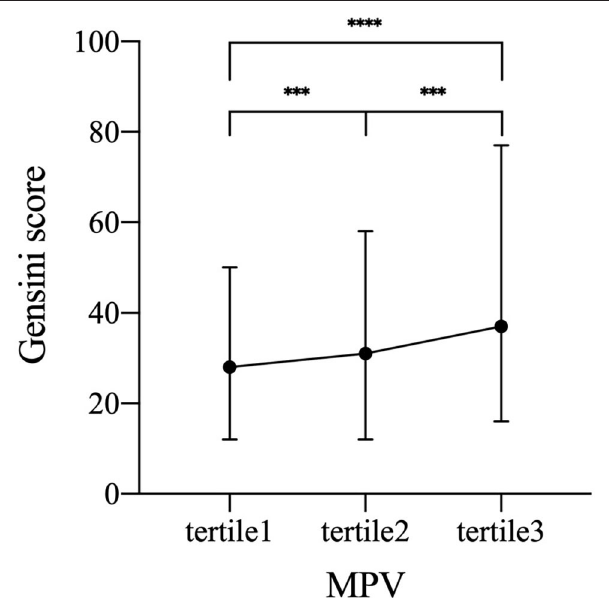
FIGURE 3 | Increased GS by MPV tertiles. Symbols and error bars represent the medians and interquartile ranges, respectively due to skewed distribution of GS. *** p < 0.001 and **** p < 0.0001. GS, Gensini score; MPV, mean platelet volume (tertile 1, MPV ≤ 10.4 fL; tertile 2, MPV 10.5–11.4 fL; tertile 3, MPV ≥ 11.5